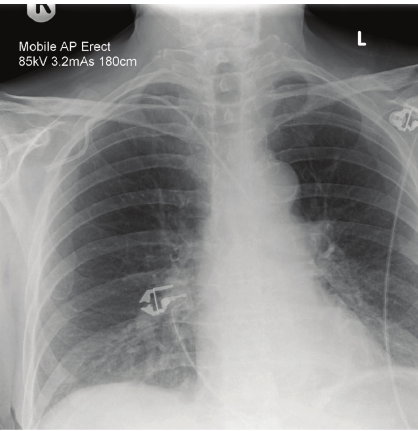
Figure 1: Chest radiograph showing abnormal position of the right subclavian line.